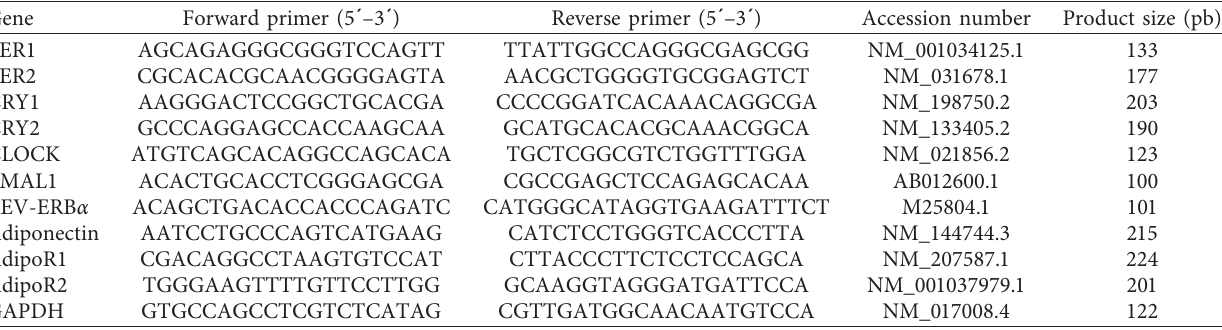
Table 1: List of primer sequences used in PCR.